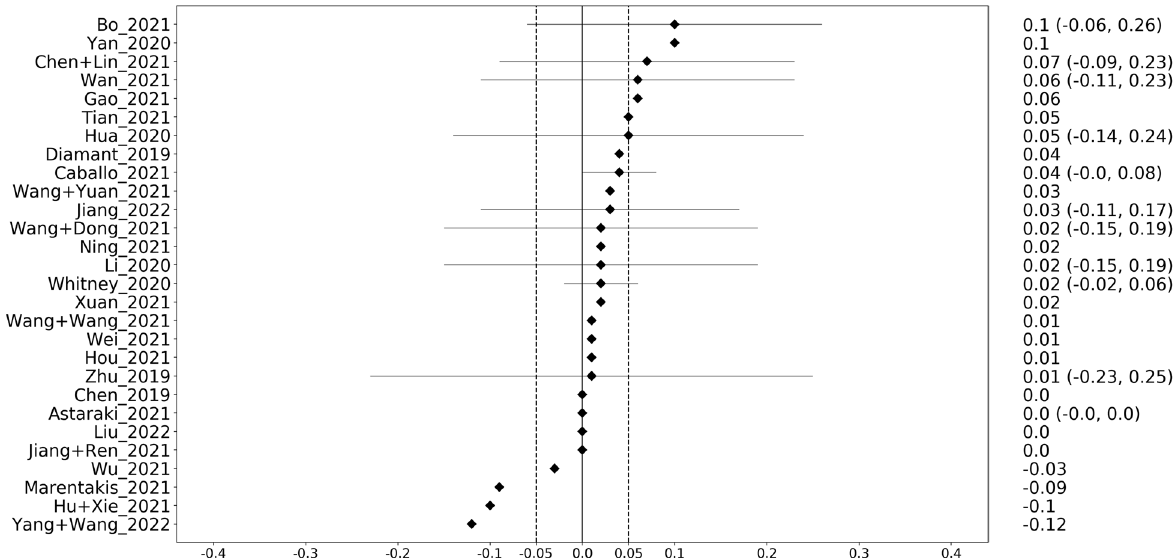
Fig. 6 Graphical display of the performance differences between the fused and the better of generic and deep models on the internal validation sets. On the right, the difference in area under the curve together with the 95% confidence interval is given. A positive difference means that the fused model performed better than the deep and the generic models